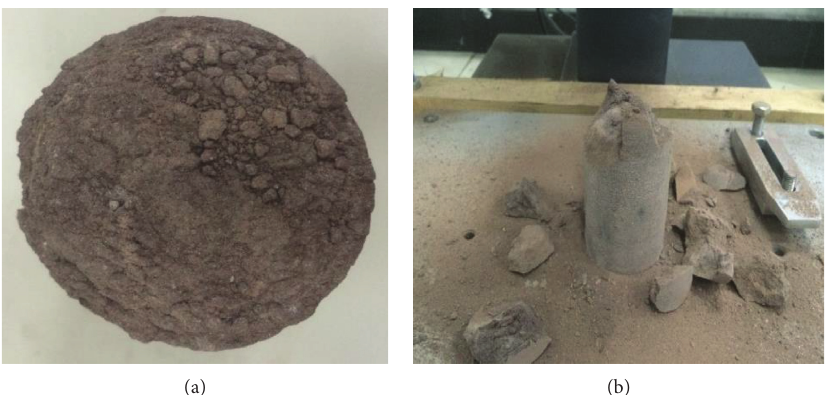
Figure 6: Failure observation of rock specimen after ultrasonic vibration. (a) Upper crushing of specimen (b) Large fragments separated from the body of the specimen.